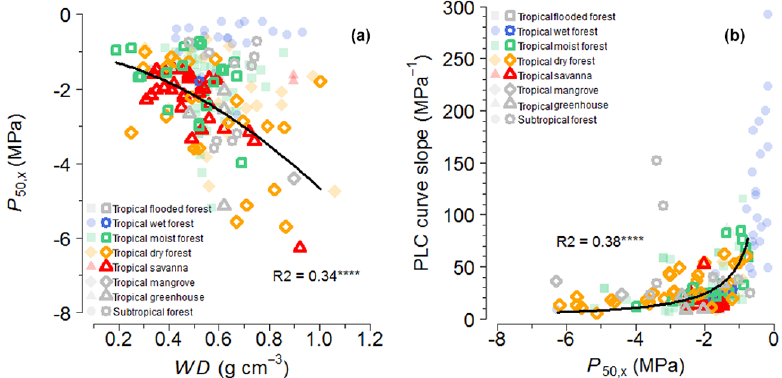
Figure 4. Tropical synthesis of xylem vulnerability. (a) Water potential at 50% loss of maximum xylem conductivity ( P 50,x ) . (b) Slope of percent loss of conductivity curve at ( P 50,x ) as a function of P 50,x : bold open symbols – bench dehydration method for P 50 measurement; light closed symbols – air injection + all other methods (see Sect. 3.1 in main text). Curves are fit through bench dehydration measurements conducted on field-derived plant material in upland tropical forests and savannas only (colored, bold open symbols). Asterisk codes for significance are the same as in Fig. 2.